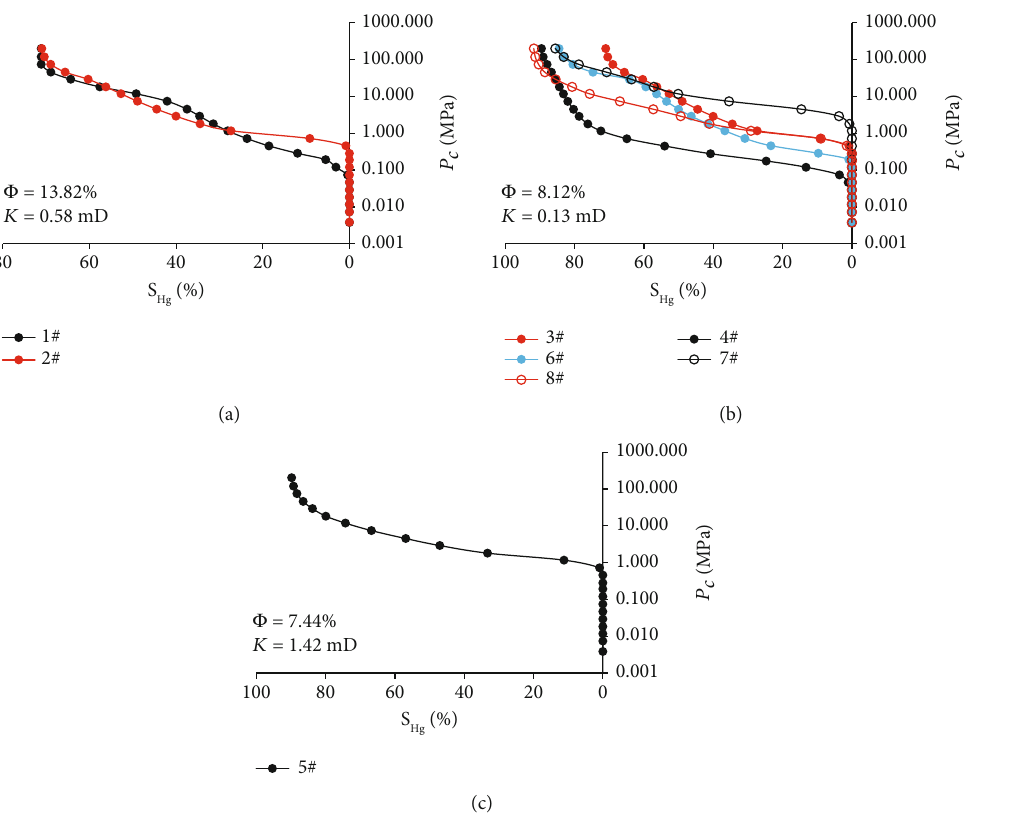
Figure 3: High-pressure mercury injection curves of the three types of